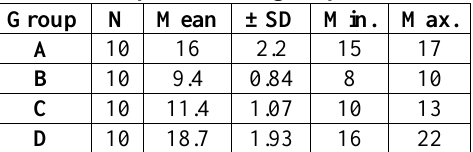
Table 2: LSD between each paired group